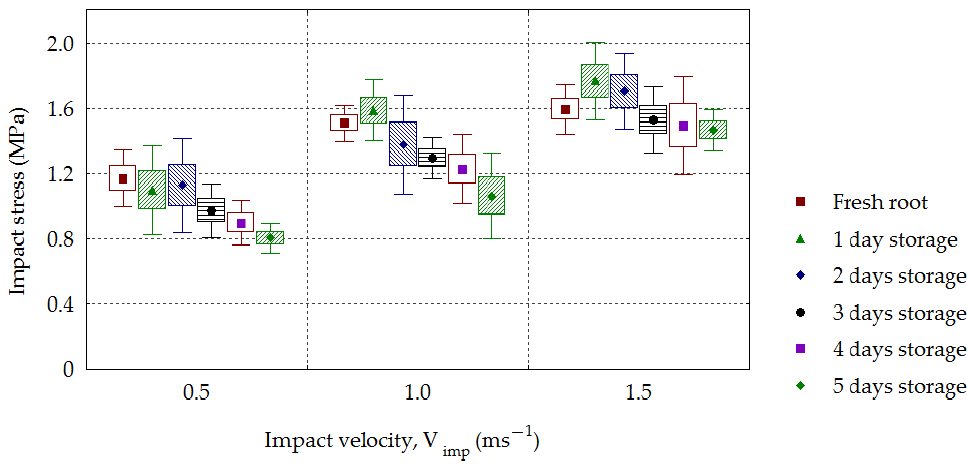
Figure 15. Dependence of the maximal impact stress ( σ imp ) on the impact velocity ( V imp ), taking the storage time ( S t ) into account.